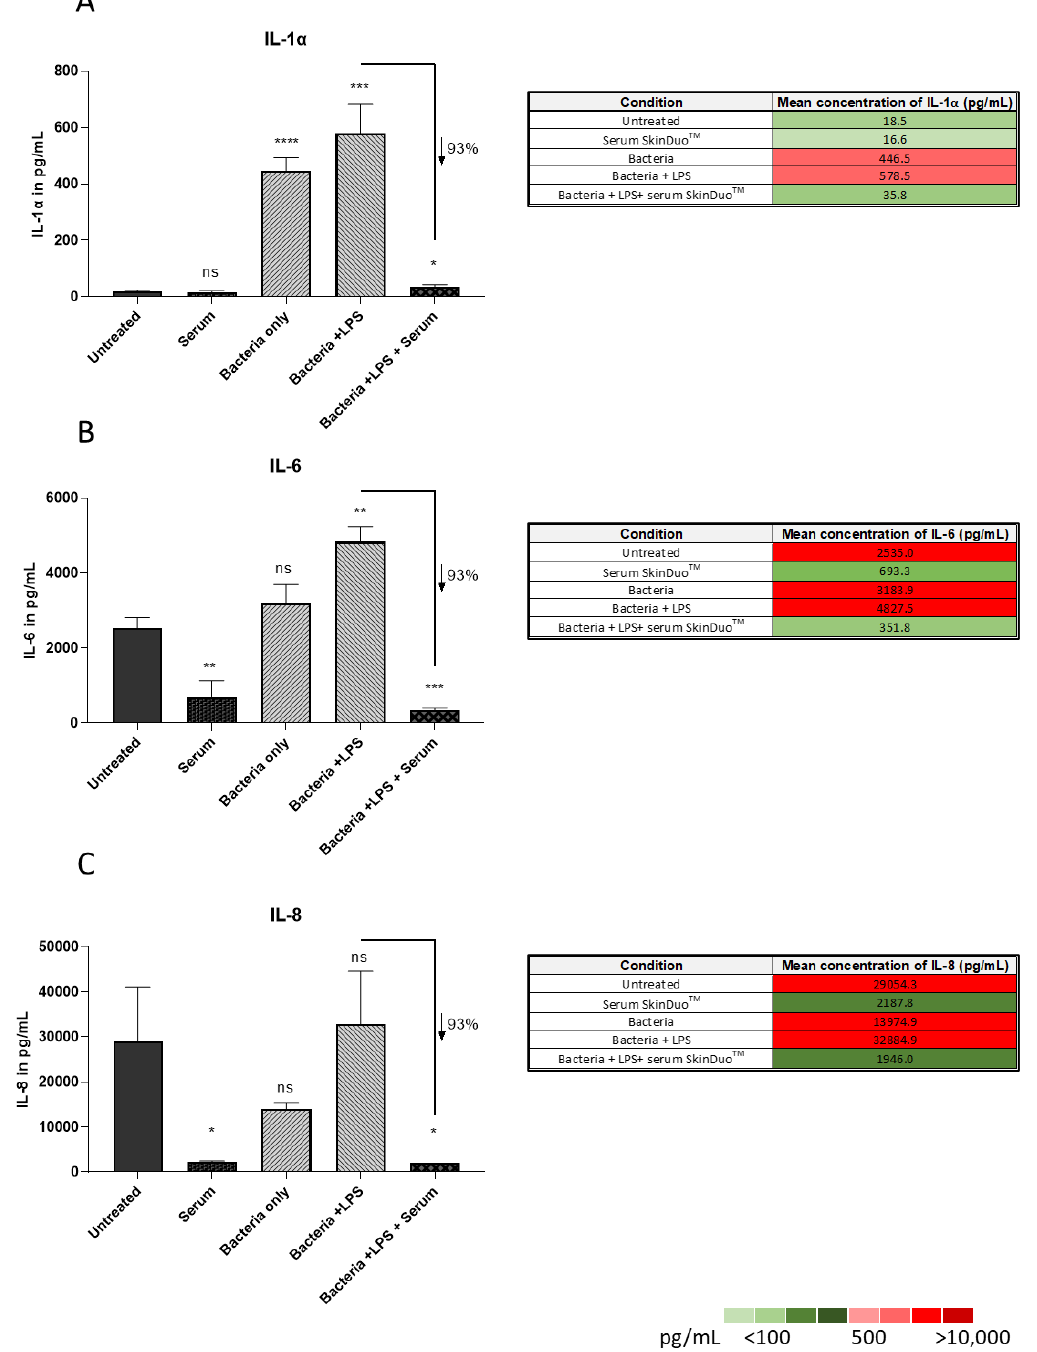
Figure 4. Interleukin measurements by ELISA significantly decreased after serum L. plantarum SkinDuo TM treatment. After 48 h of serum (SkinDuo TM ) application to the co-culture (sebocytes/bac- teria: C. acnes and S. epidermidis ), culture supernatants were collected, and interleukin assays were performed. The conditions tested were for: untreated, serum SkinDuo TM , bacteria, bacteria + LPS, bacteria + LPS + serum ( A – C ). The serum SkinDuo TM statistically reduced the levels of IL- 1 α, IL -6 and IL-8 when compared to the in vitro human cellular model for acne and challenged with LPS. t - test untreated (sebocytes) Vs.: serum (SkinDuo TM ), bacteria only, bacteria + LPS, bacteria + LPS + serum. Unpaired t -test: 0.1234 (NS), 0.0332 (*), 0.021 (**), 0.0002 (***), <0.0001 (****), percentage